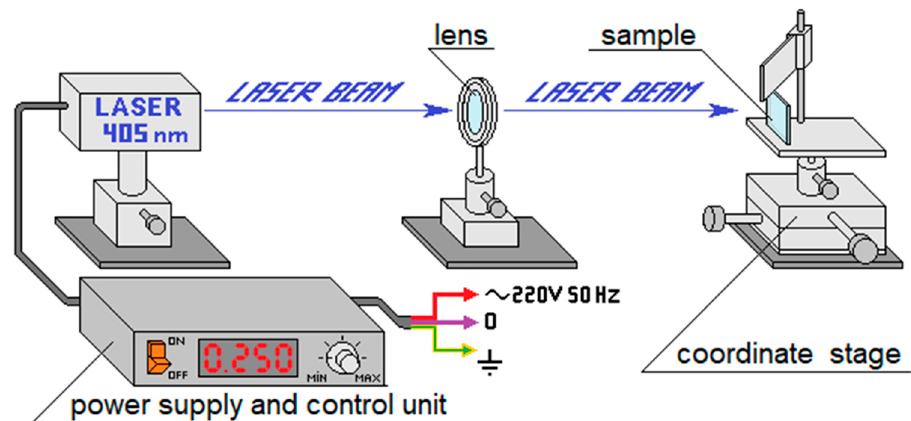
Figure 1. Scheme of the experimental setup.